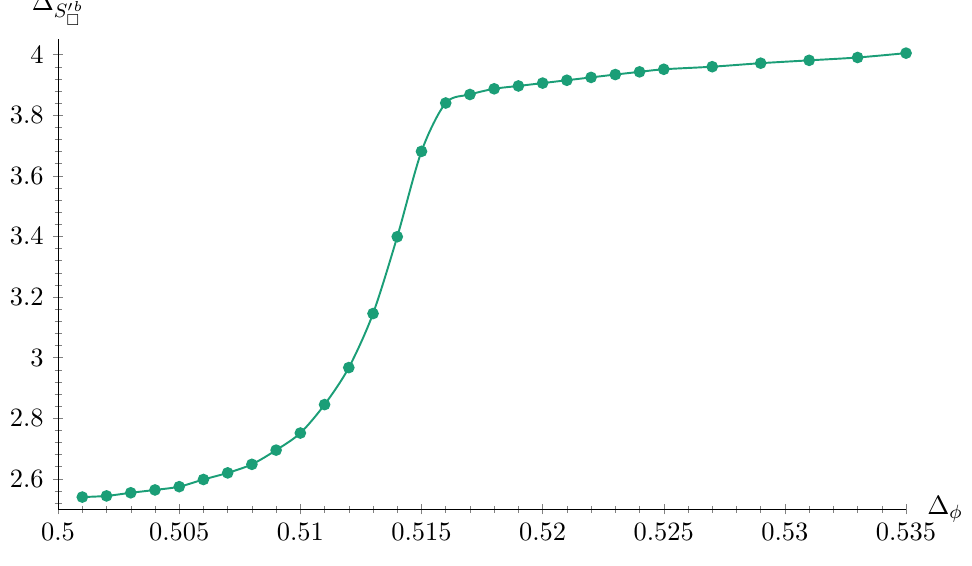
Figure 7 . The dimension of S 0 b of (cid:12)gure 2. The markers indicate the points at which we have computed the spectrum. is shown in (cid:12)gure